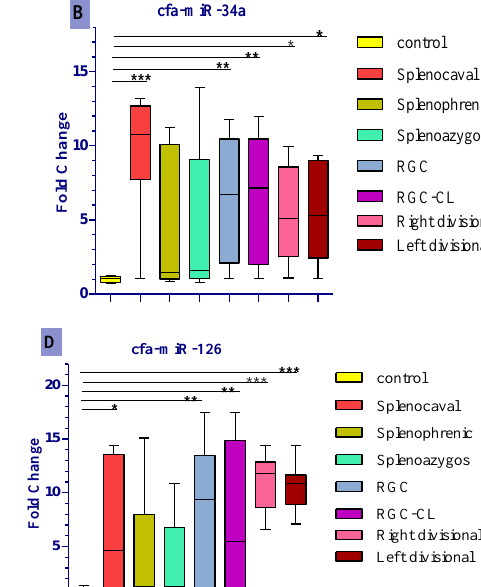
or splenoazygos shunts compared with the control. 268